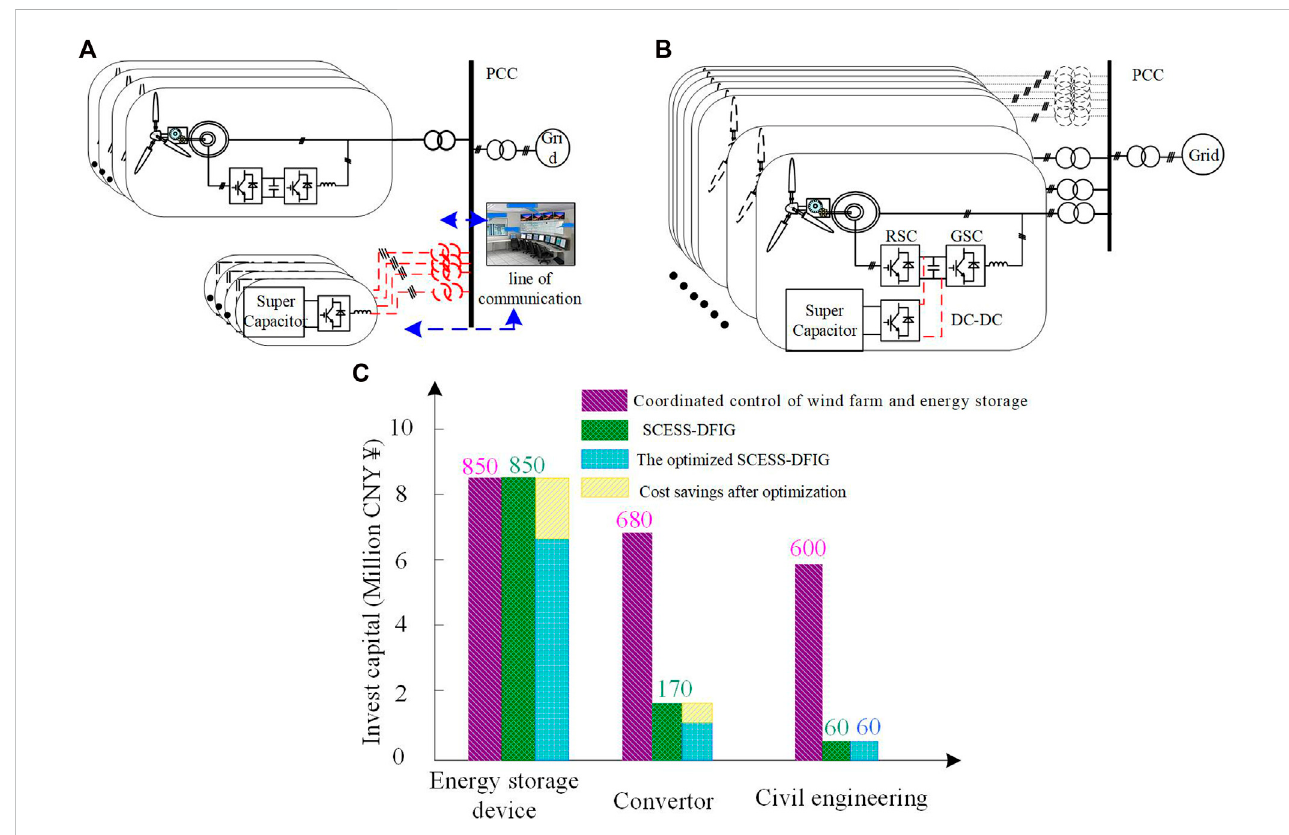
FIGURE 1 Architecture of energy storage system participating in wind farm power regulation and economic comparison between